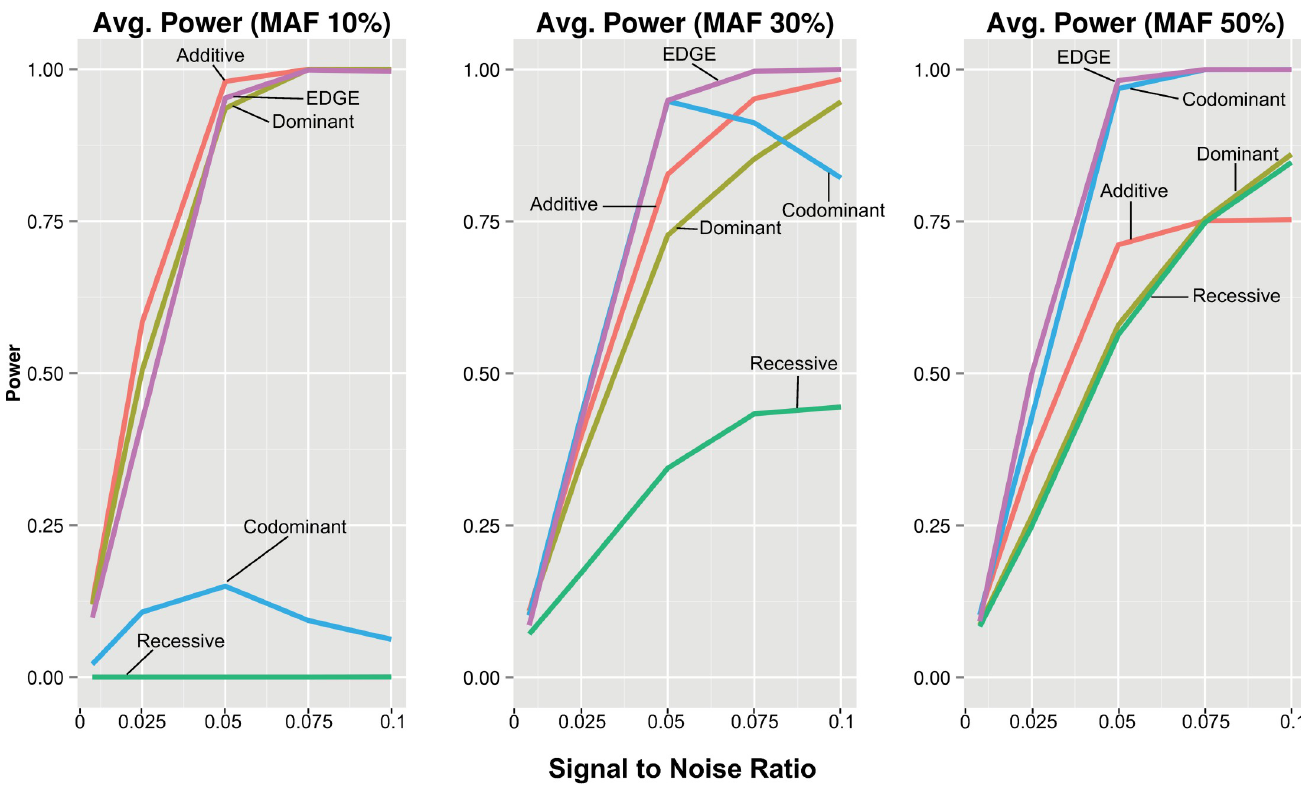
Fig 5. Average power for standardized signal to noise ratio across all pairwise interaction models at 10%, 30% and 50% MAF. Average power of each encoding was calculated for standardized signal to noise ratios and plotted by increasing signal to noise ratios for the pairwise model SNP-SNP interaction models using each encoding: additive (red), dominant (yellow), recessive (green), codominant (blue), and EDGE (purple).